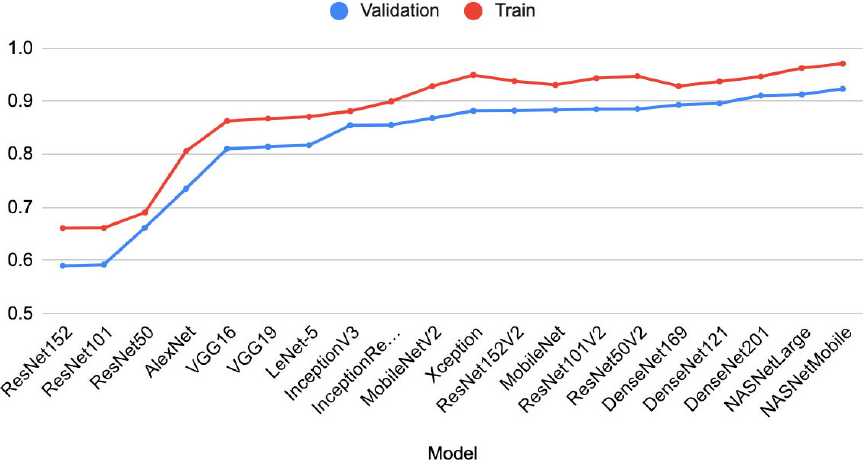
Fig. 4. Accuracy of different CNN architectures on train and validation